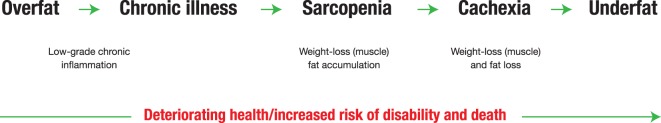
The overfat–underfat progression. The common spectrum of deteriorating health during the lifespan from the overfat to underfat state.